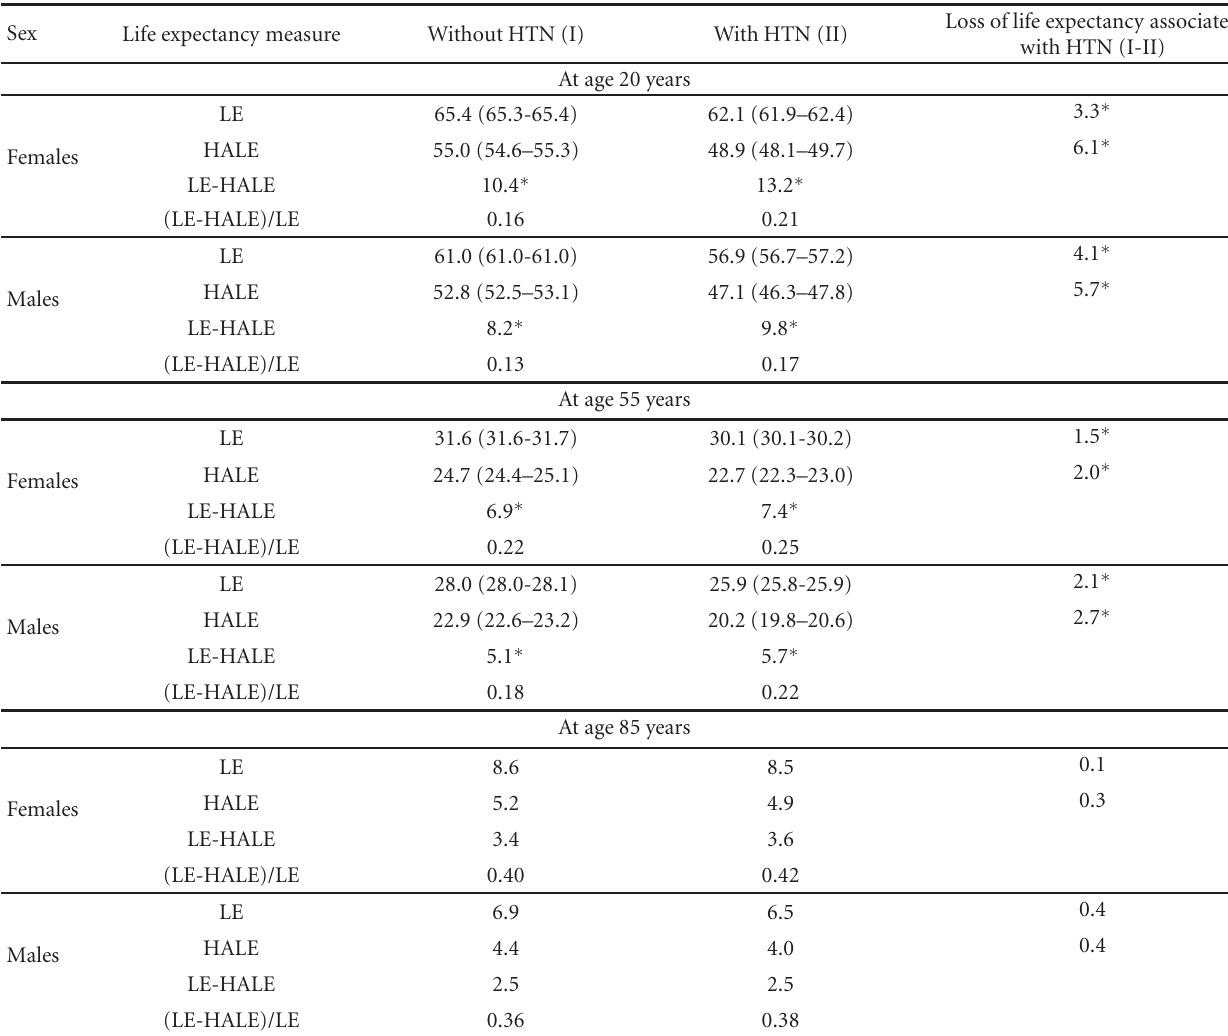
Table 2: Life expectancy (LE), health-adjusted life expectancy (HALE) (With 95% Confidence Intervals), and Loss of LE and HALE at selected ages, by hypertension (HTN) status and sex, Canada, 2004 to 2006. (Dataset for this study excluded Quebec, Nunavut and Northwest